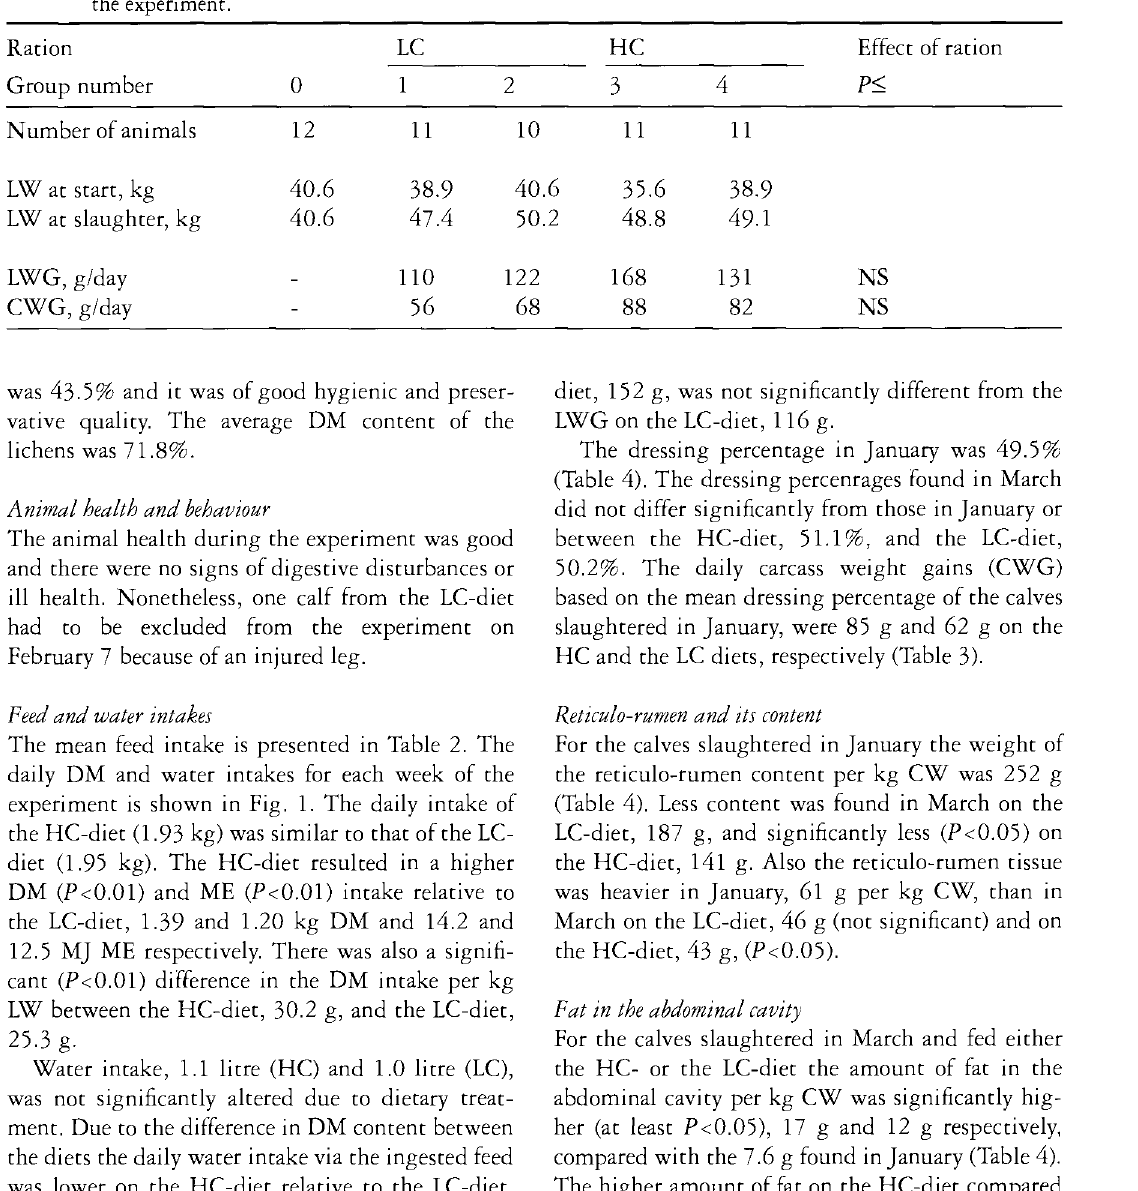
Table 3. Number of animals, live weight (LW) at start and slaughter and daily live weight gain (LWG) and carcass weight gain (CWG) in groups of reindeer calves (cf. Table 2). Group number 0 was slaughtered at the start of the